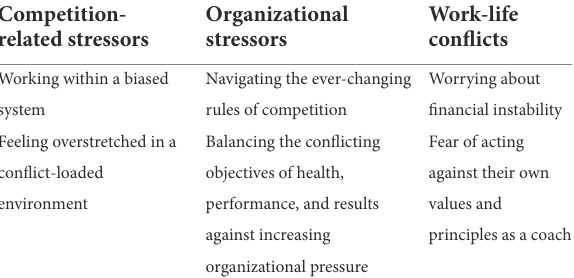
TABLE 3 Summary of the themes and subthemes of the stressors experienced by coaches. Competition- related